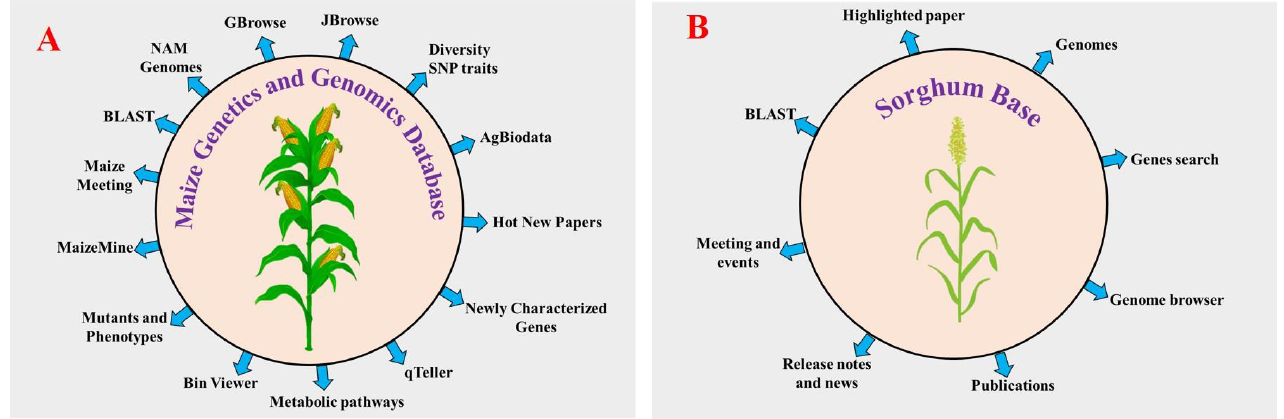
Figure 3. Graphical illustration of the maize genetics and genomics database (MaizeGDB) and sorghum base. Various tools have been implemented in the MaizeGDB ( A ) (https://www.maizegdb.org (ac- cessed on 10 October 2022)) and sorghum base ( B ) (https://www.sorghumbase.org (accessed on 18 October 2022)), both of which help to collect all molecular data from the